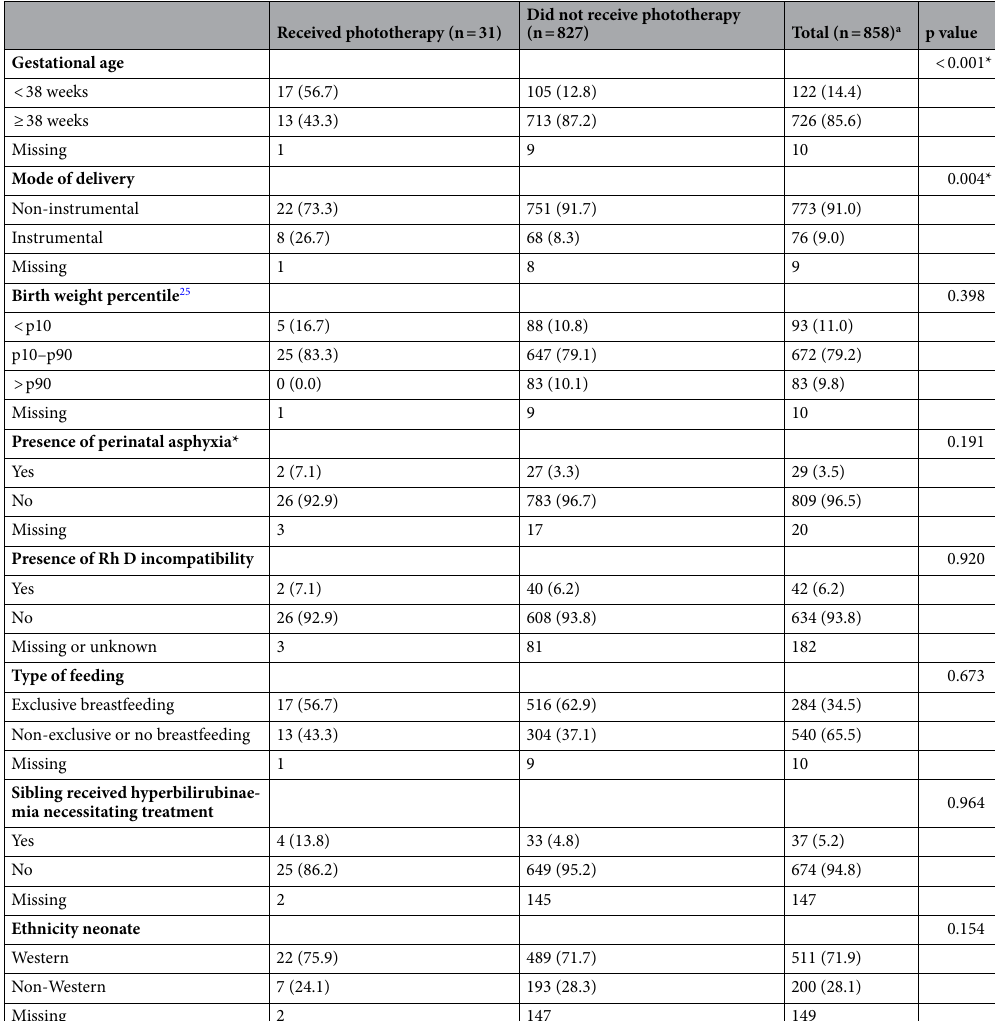
Table 4. Association of risk factors with receiving treatment for hyperbilirubinaemia. a The need for phototherapy was unknown for two neonates, as daily measurements and parental questionnaire were not filled out. These neonates were excluded from this analysis. *Defined as Apgar score < 5 at 5 min and/or umbilical cord pH < 7.0. According to the definition of the Dutch TSB